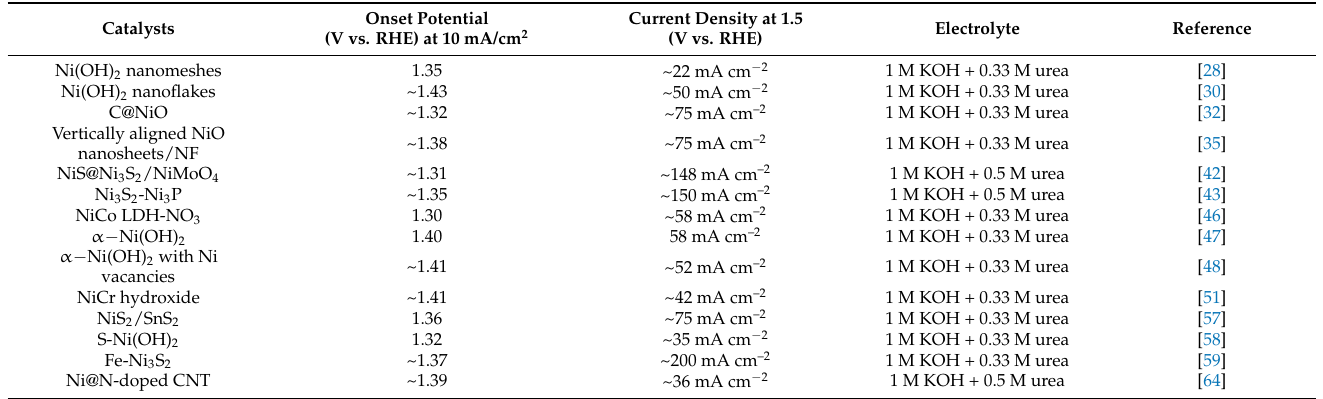
Table 1. Comparison of UOR performances of various Ni-based catalysts. Catalysts Onset Potential (V vs. RHE) at 10 mA/cm 2 Current Density at 1.5 (V vs. RHE) Electrolyte